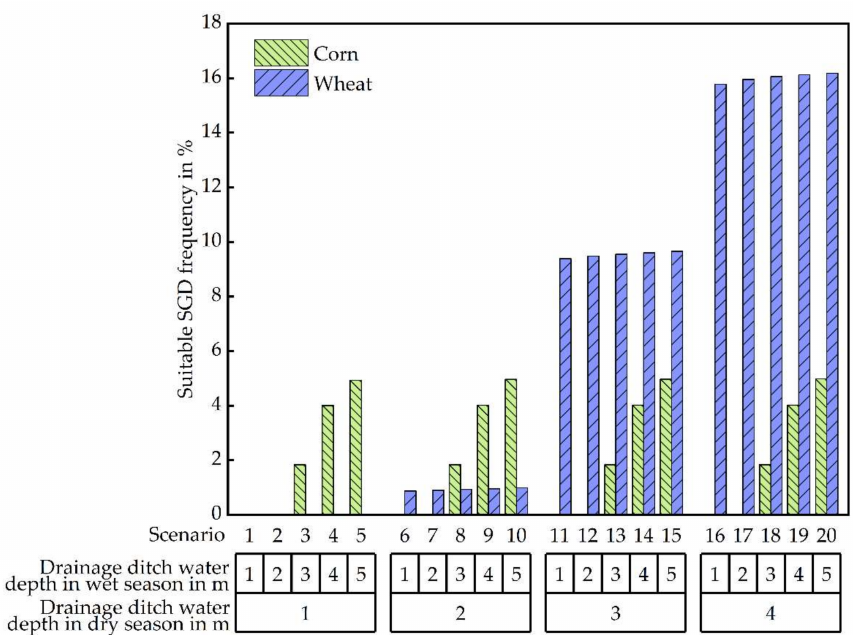
Figure 6. Frequencies of SGDC for corn and wheat under different ditch-water-depth scenarios from 1989 to